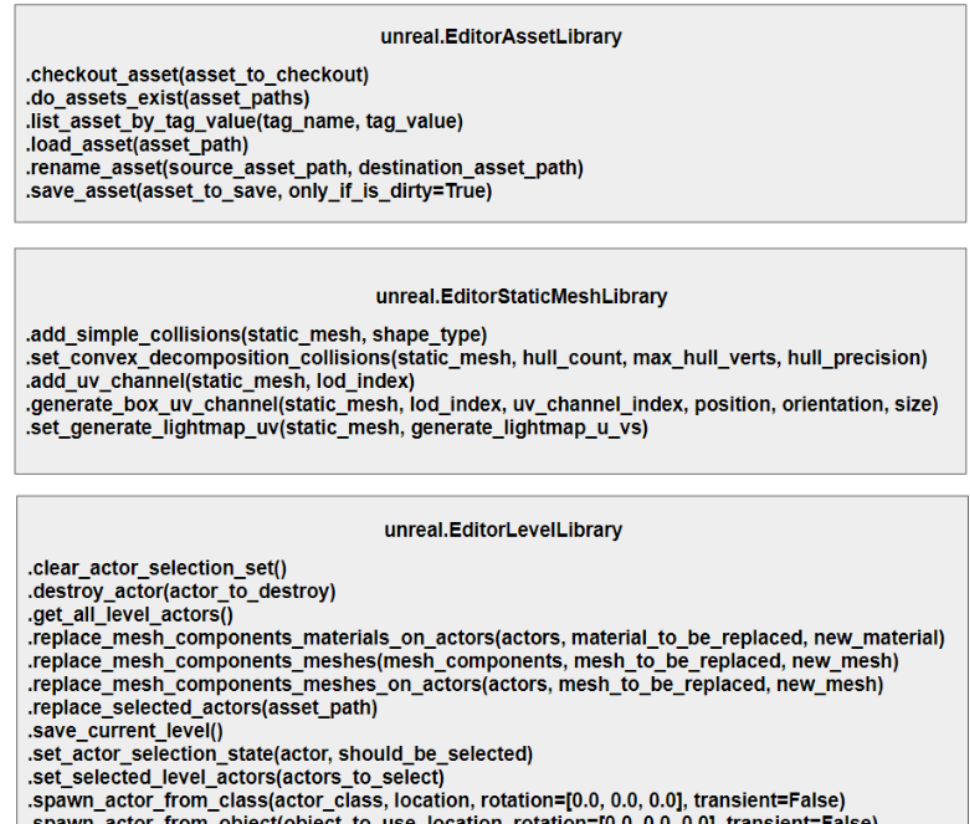
Figure A2. Unreal documentation: some generally useful